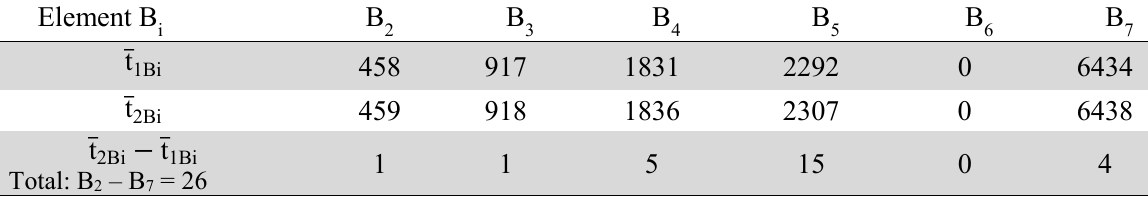
Number of time steps for required buffer size computations Element B i